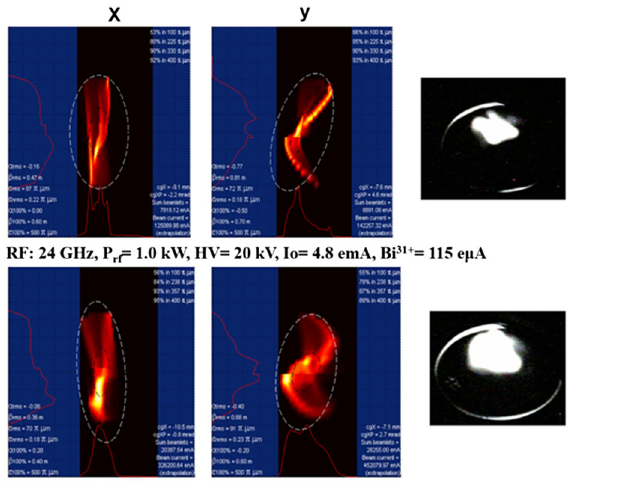
FIG. 25. Beam emittance phase-space patterns and beam images for the beam 209 Bi 31 þ at different conditions for SECRAL operating 24